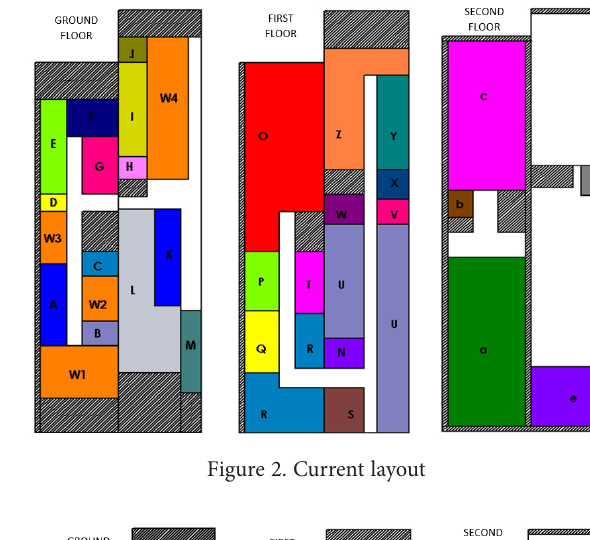
Figure 2. Current layout